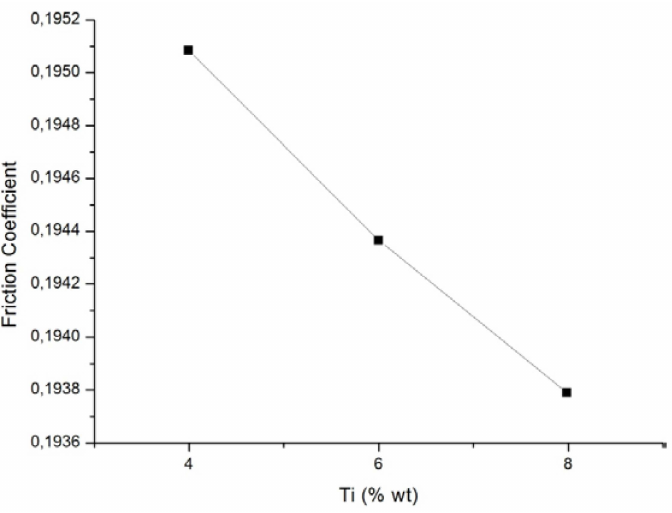
Figure 7. Average friction coefficients of Al-Ti